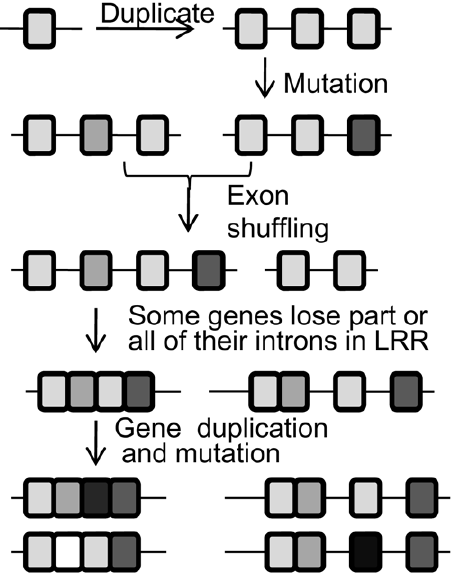
Figure 4. The Model for LRR domain evolution of LKs. Boxes indicate exons, and lines indicate introns.